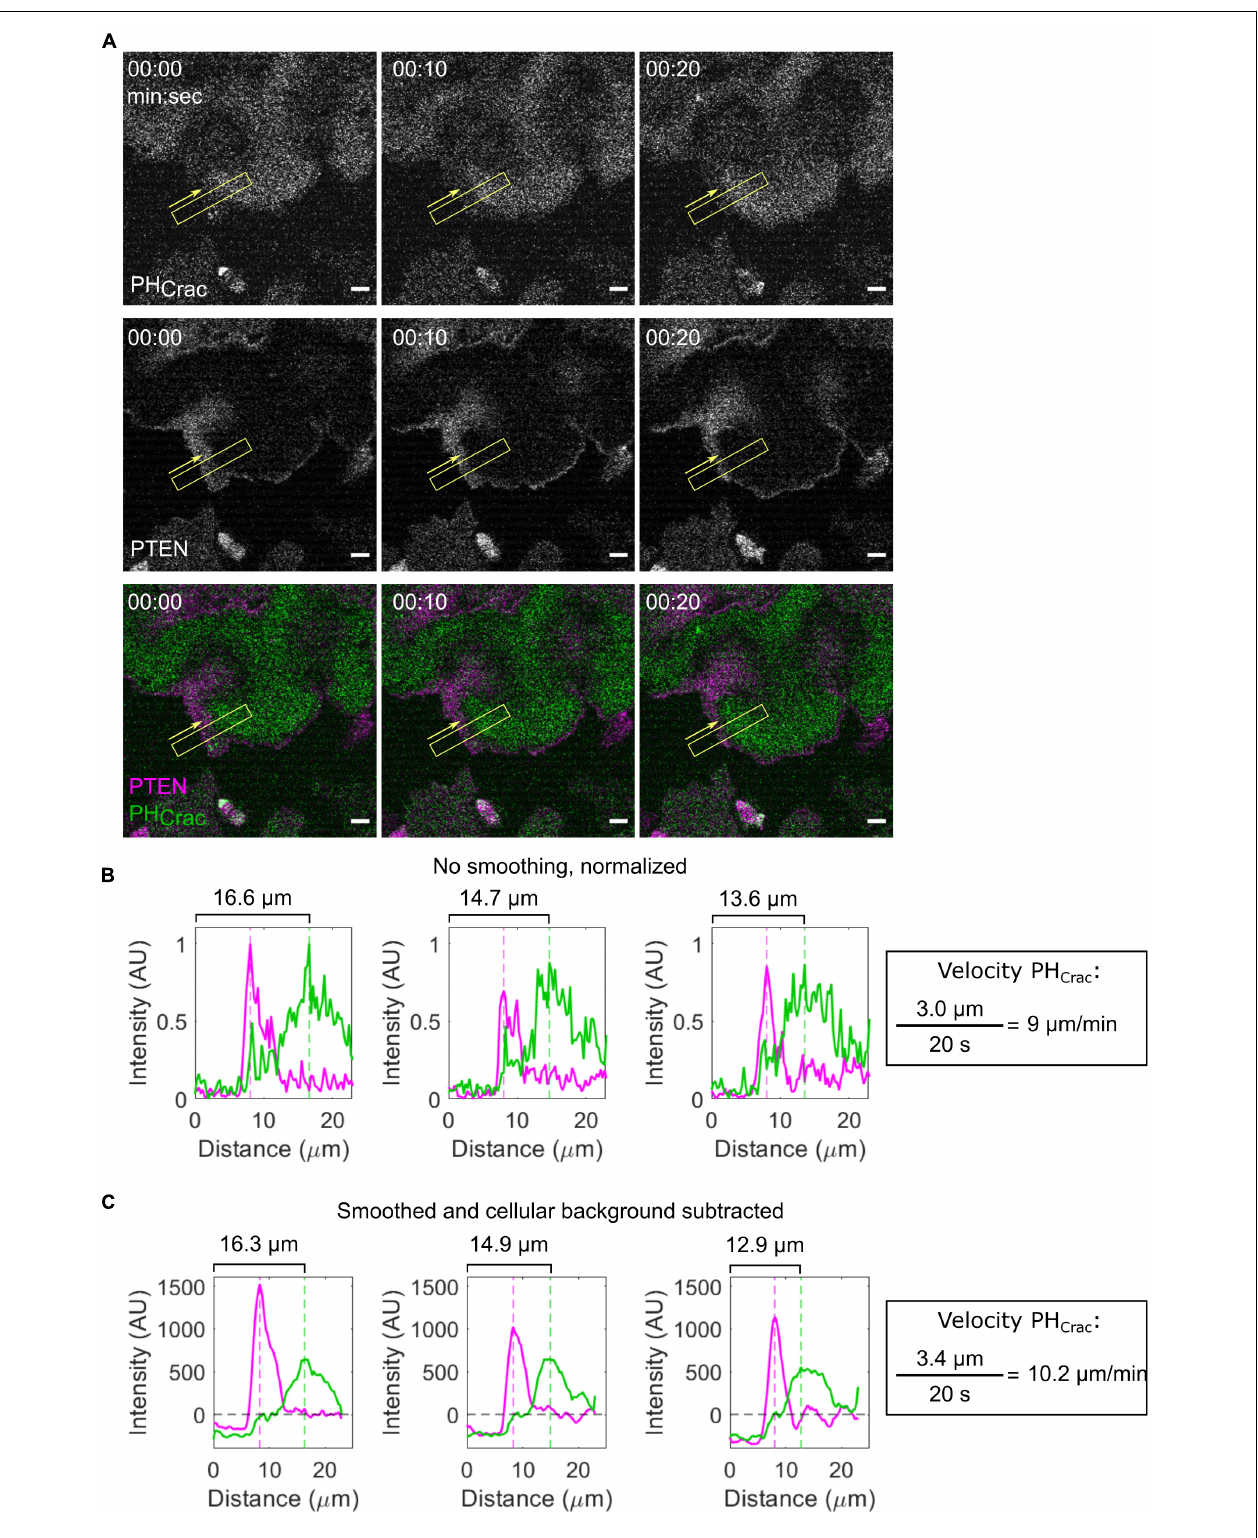
FIGURE 6 | Measuring STEN wave properties. (A) Scanning confocal imaging of PIP3 (PH Crac ) and a back protein (PTEN) in a giant AX2 Dictyostelium cell. Yellow boxes indicate the location and width of the intensity line scan across a membrane wave. Yellow arrows indicate the direction of the line scan. (B,C) Raw (B) and smoothed and background-corrected (C) Intensity line scans corresponding to the timepoints in panel (A) . The position of the linescan area does not change, while the peak position of PH CRAC decreases. This change can be used to calculate the velocity of the front wave.